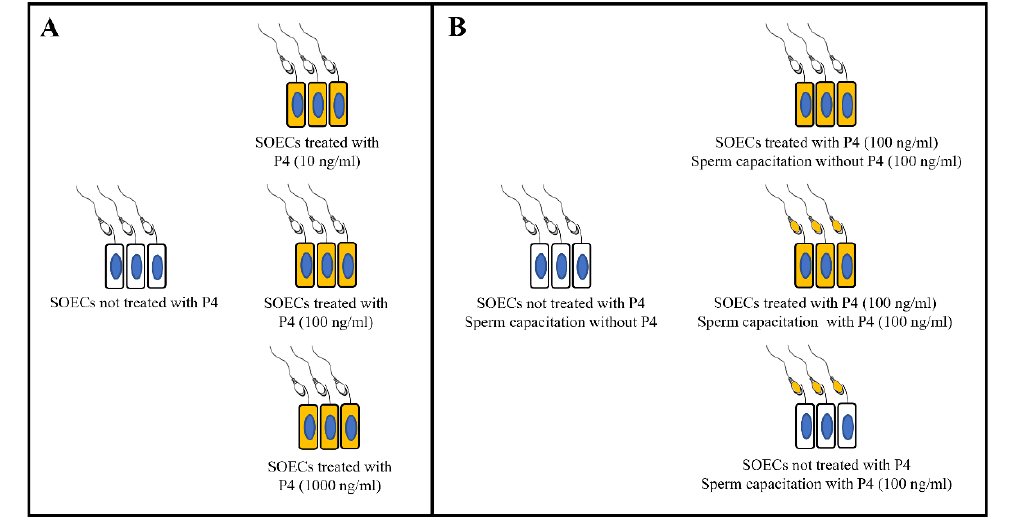
Figure 1. Experimental design for IVF . ( A ) Experimental groups to identify the most effective P4 concentration. ( B ) Experimental groups using the most effective P4 concentration and sperm capacitation with and without P4 (100 ng/mL) in the presence of SOECs previously treated or not with P4.